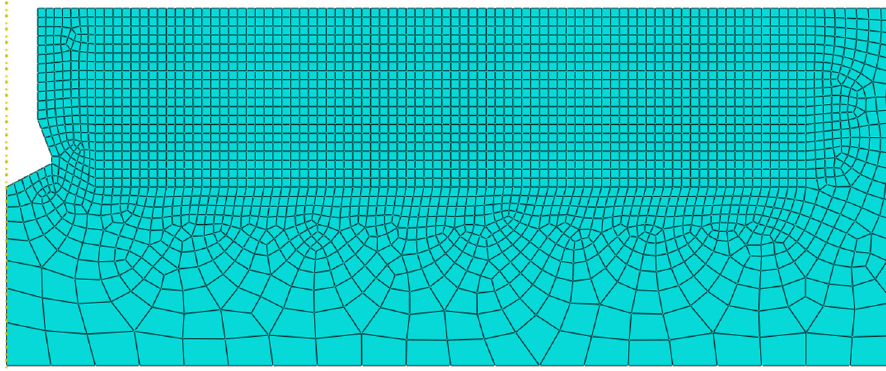
Figure 17. The grid of the simulation model of the pull-out test. Figure 15. The grid of the simulation model of the pull-out